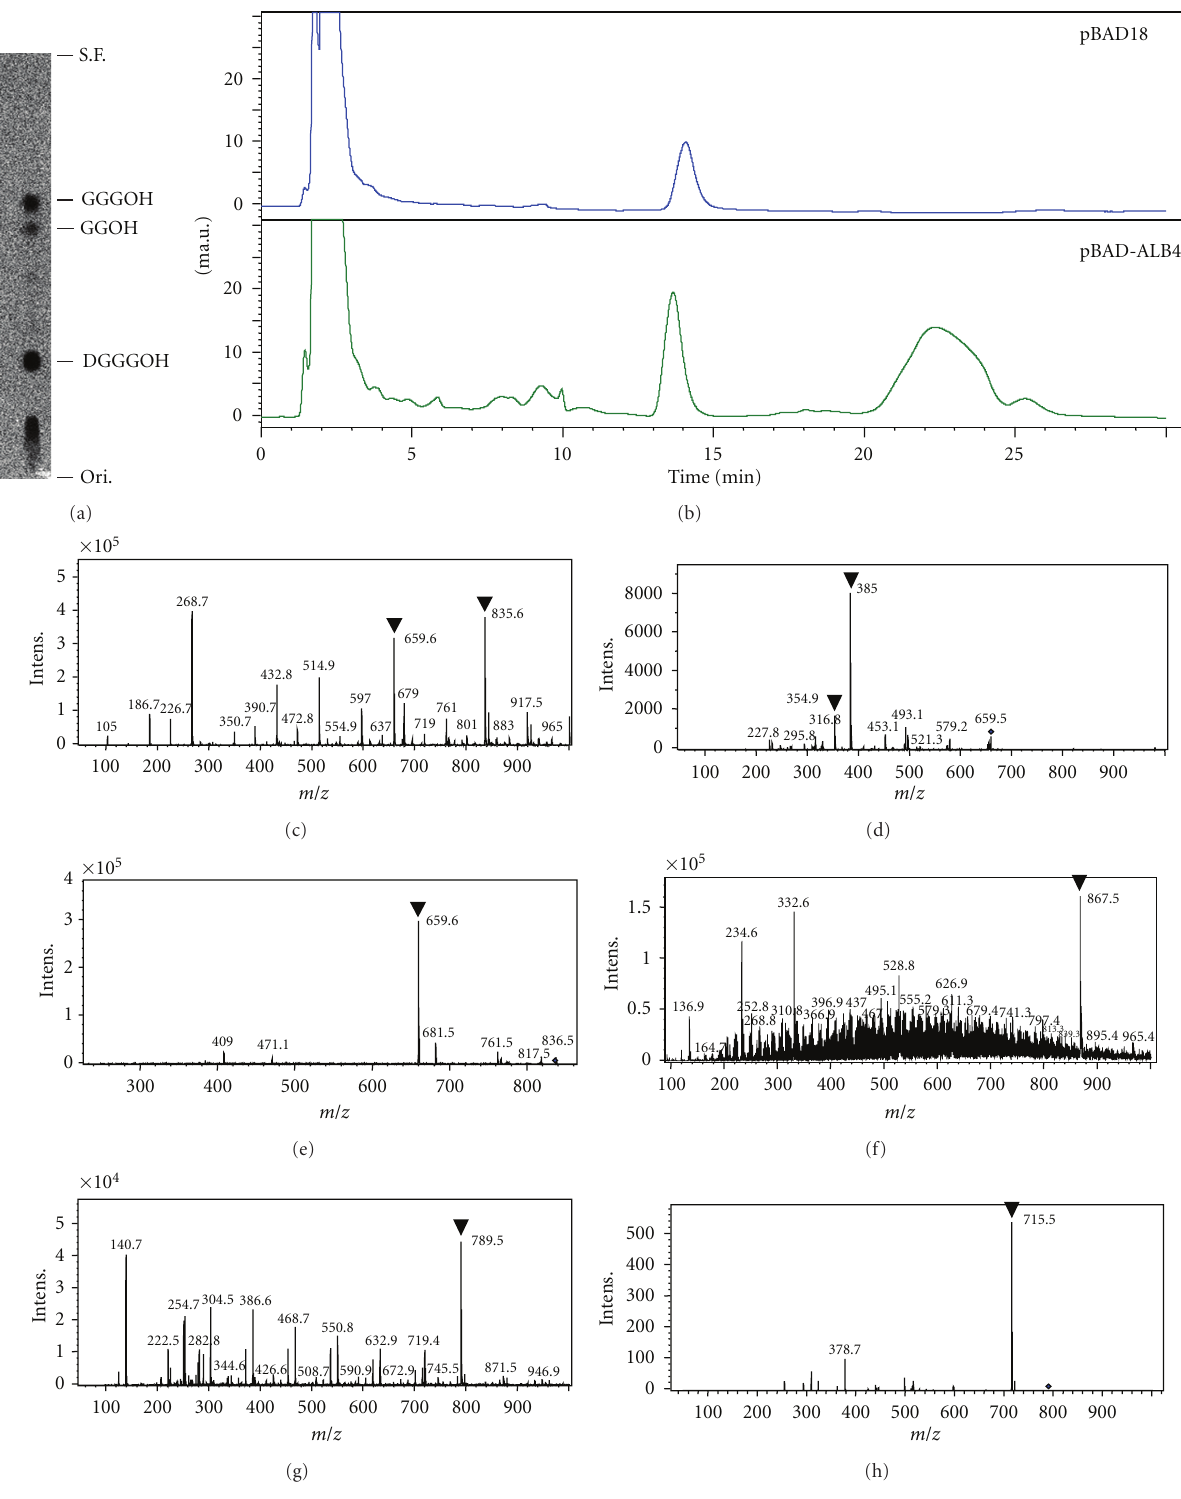
Figure 3: Radio-TLC and LC/ESI-MS analyses of the archaeal-type lipids synthesized in E. coli . (a) Crude extract from E. coli harboring pBAD-ALB4 was incubated with FPP, [ 14 C]IPP, and DHAP. Reversed-phase radio-TLC analysis of the products was performed after dephosphorylation. S.F., solvent front; Ori., origin. (b) LC profiles of lipids extracted from E. coli harboring pBAD-ALB4 (lower) or its parent plasmid, pBAD18 (upper). (c) Positive ESI-MS ion spectrum of a peak in (b) around 22 min. (d) and (e) MS/MS analyses of the ions in (c), with m/z of 659.6 and 835.6, respectively. (f) Positive ESI-MS ion spectrum of the LC peak corresponding with that analyzed in (c). Exclusively for this analysis, the elution bu ff er was changed from sodium based to potassium based. (g) Negative ESI-MS ion spectrum of a peak in (b) around 22min. (h) MS/MS analysis of the ion in (g), with an m/z of